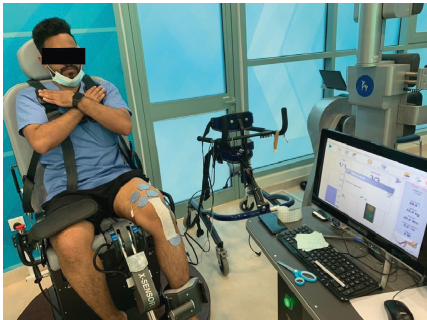
Figure 2: Participants’ position during quadriceps strength measurement.